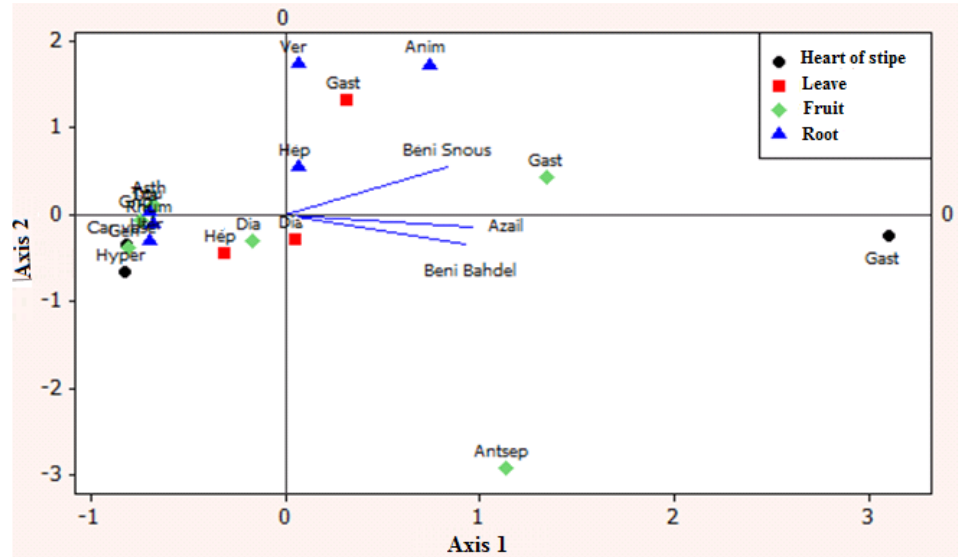
Figure 4. Chart of the various treated diseases and Communes prospected on the factorial axis 1 and 2. Abbreviations are: Dia: diabetes; Hép: hepatitis; Gast: gastrointestinale attacks; Anim: Anemia; Ver: intestinal worms; Utér: cleaning of the uterus after accouchement; Rhum: rheumatism; Hype: hypertension; Car vasc: cardio vascular disease; Gen: gingiva; Grip: influenza, Tou: coughing; Asth: asthma; Antsep: dyspepsia or